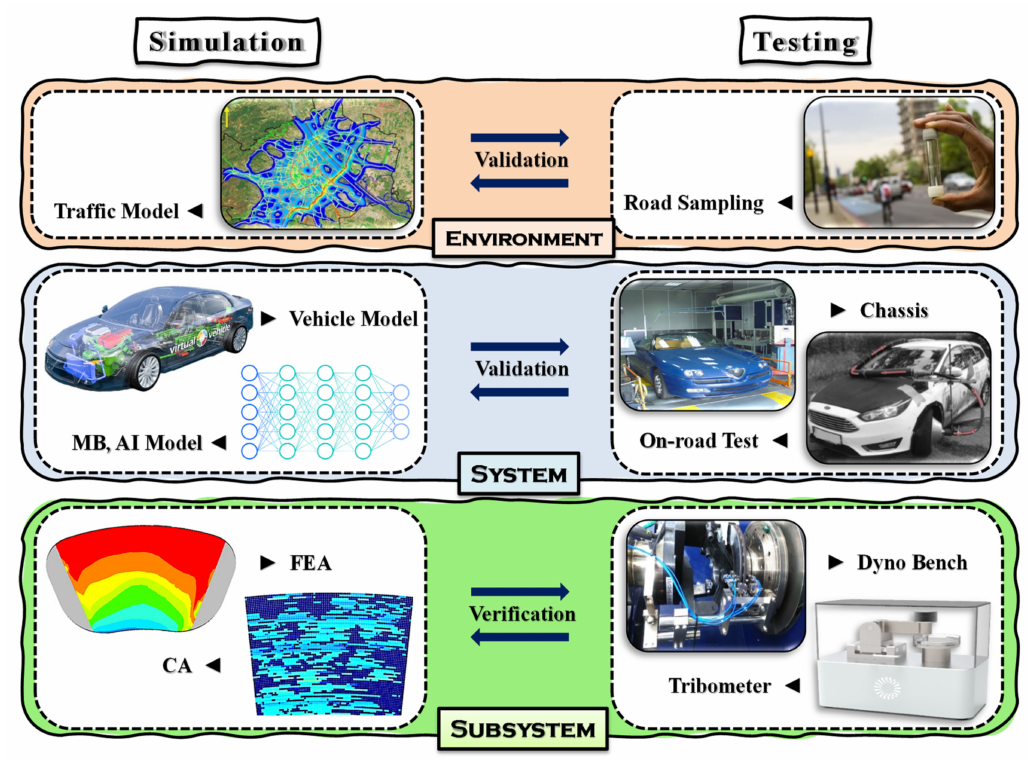
Figure 2. An overview scheme of the proposed brake wear